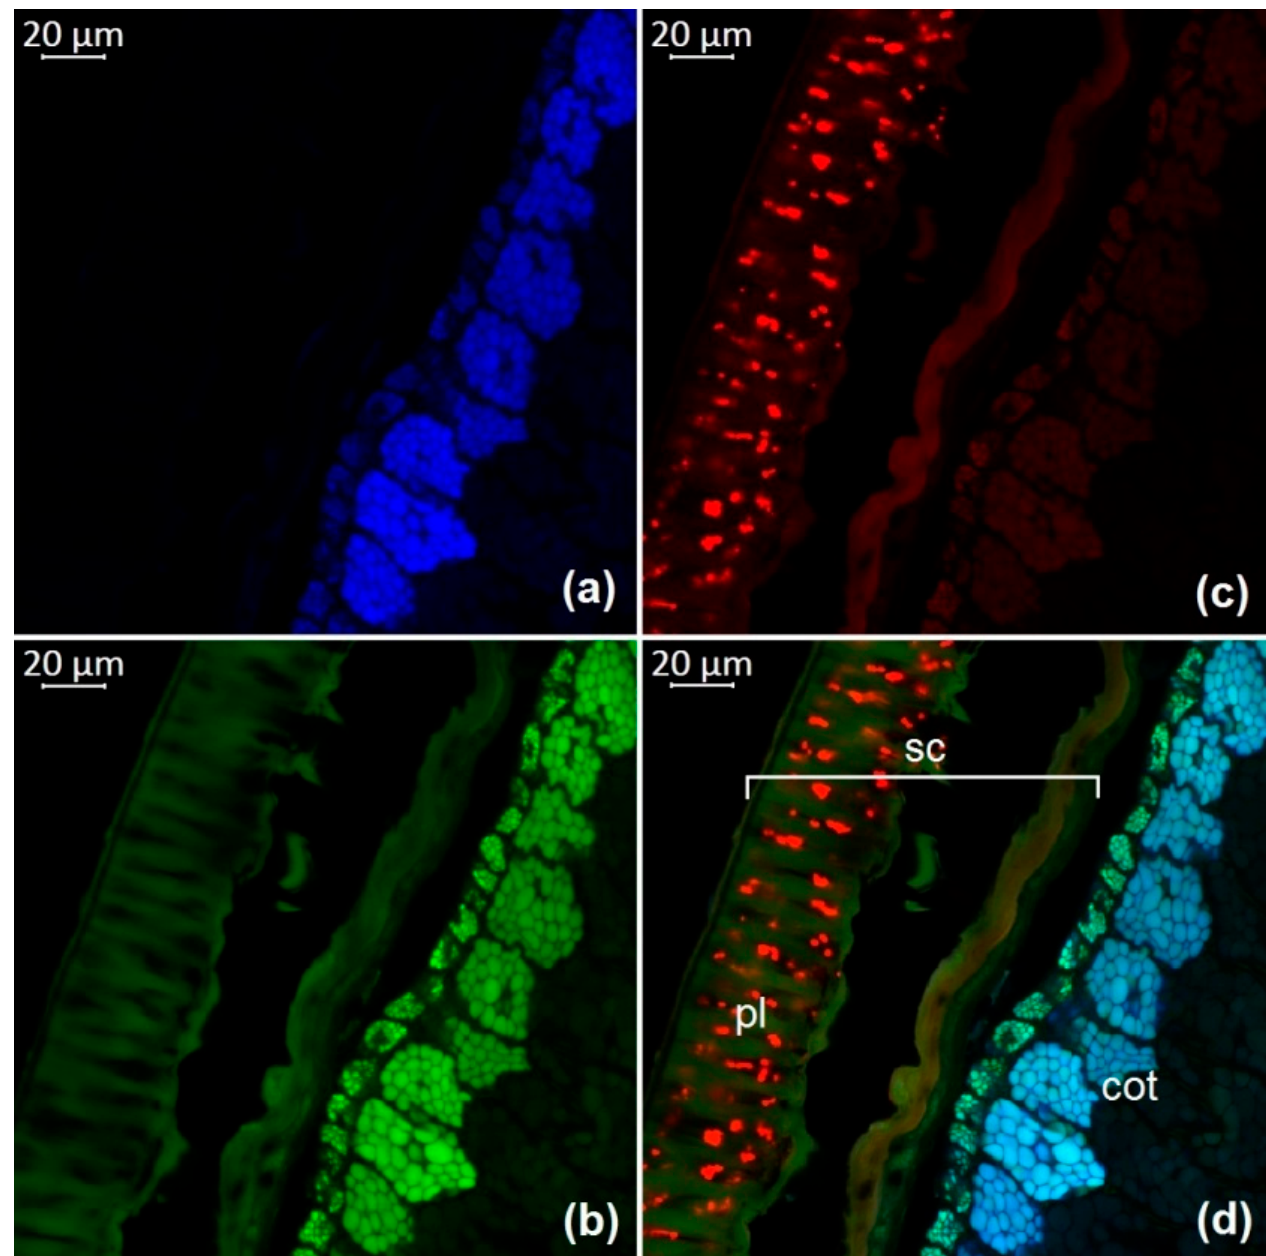
Figure 5. A transverse section of a soybean seed (variety k-5367): ( a ) excitation at 405 nm with emission in the range of 400–475 nm (blue); ( b ) excitation at 488 nm with emission in the range of 500–545 nm (green); ( c ) excitation at 488 nm with emission in the range of 620–700 nm (red); ( d ) merged; cot, cotyledon; pl, palisade layer; sc, seed coat.